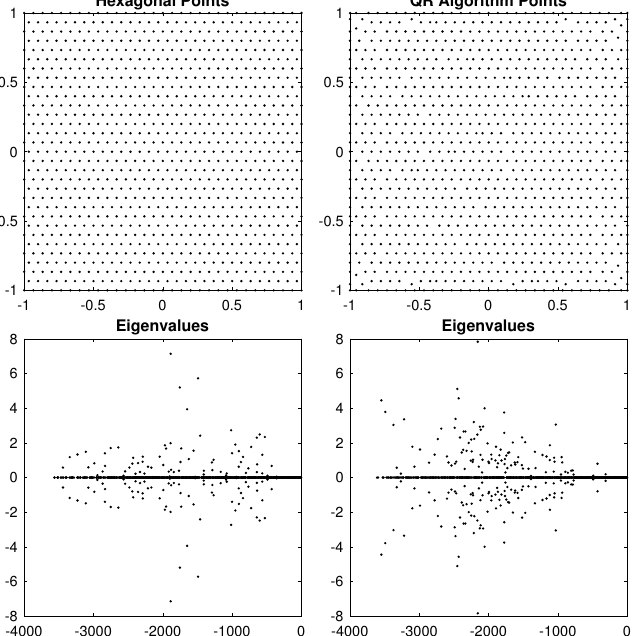
Figure 13. Hexagonal points and resulting MCpQR algorithm points with Dirichlet Laplacian eigenvalues. No interior points are